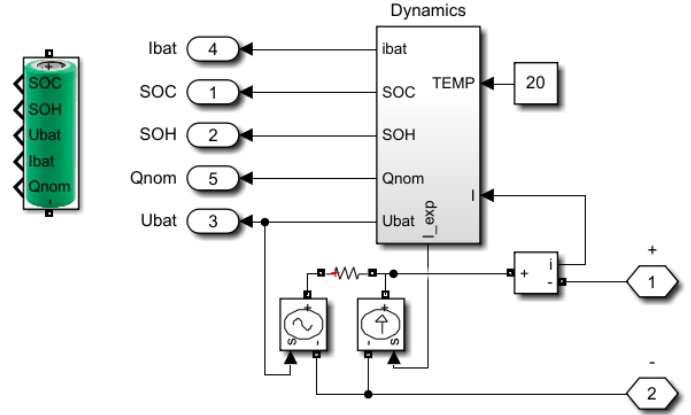
Figure 25. Final digital twin based on an empirical model of the Li-ion